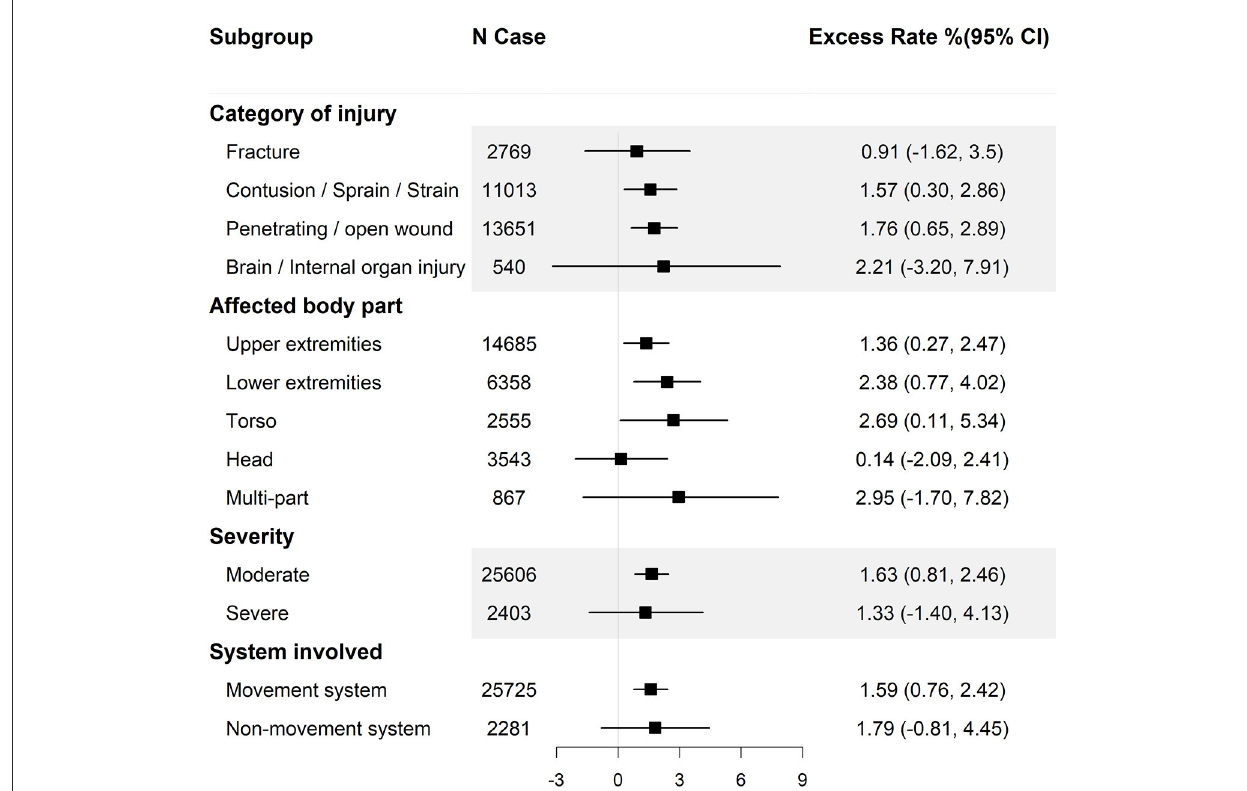
FIGURE3 Excess rate (and 95% confidence intervals) of injuries at work associated with 10mm increase in precipitation by nature of injury, injury area, severity, and system involved. CI, confidence